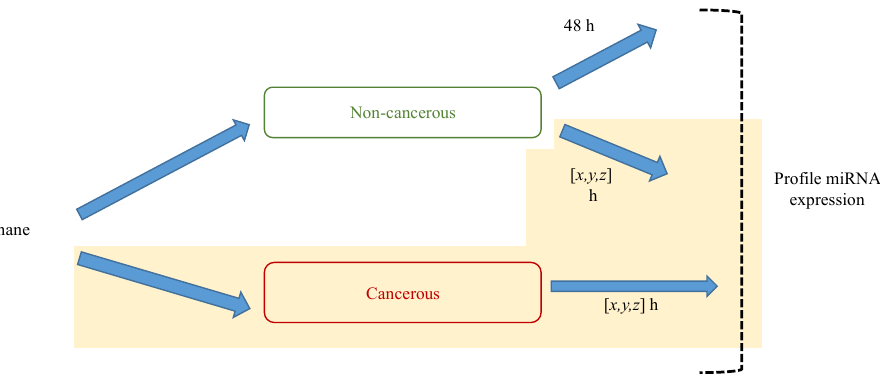
Figure 6. A basic overview of the miRNA ‐ profiling experiments carried out by Slaby et al. and suggested further experiments. Slaby et al. treated non-cancerous colonic cell lines with sulforaphane, then profiled differences in miRNA expression at 48 h. Possible further experiments involving colorectal cancer cell lines and additional time points are illustrated and highlighted in yellow.